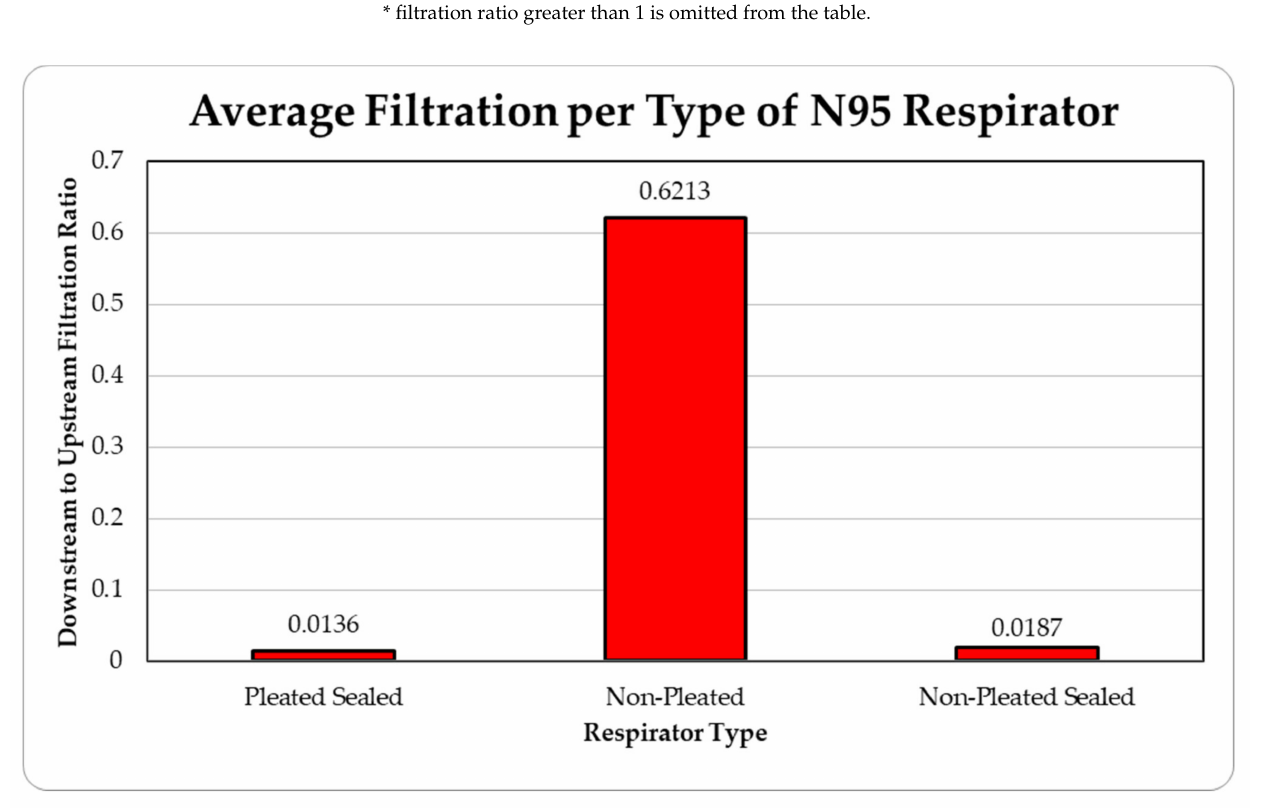
Figure 13. Average filtration ratios of total particles per type of respirator at the Asphalt